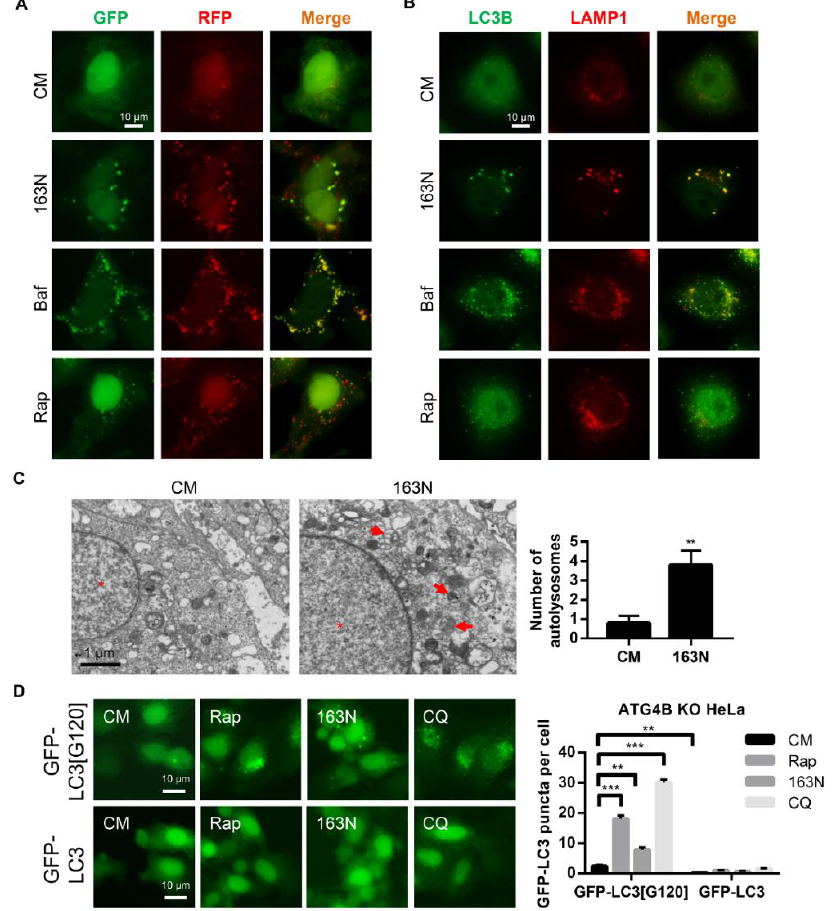
Figure 4. 163N increases the accumulation of autolysosomes. ( A ) HEK293A cells expressing green fluorescent protein (GFP)-red fluorescent protein (RFP)-LC3 were treated with 163N (10 µ M), rapamycin (Rap) (1 µ M) or Baf (0.5 µ M) for 6 h, then the colocalization of GFP and RFP puncta was detected. ( B ) HeLa cells were treated with 163N (10 µ M), Rap (1 µ M) or Baf (0.5 µ M) for 6 h, then immunostaining was used to detect LC3B and LAMP1. The colocalization of LC3B and LAMP1 was measured. ( C ) HeLa cells were treated with 163N (10 µ M) for 6 h, then transmission electron microscopy (TEM) was used to detect the ultrastructure of HeLa cells. Red arrows indicate normal autolysosome structures. ( D ) ATG4BKO HeLa cells expressing GFP-LC3[G120] or full length GFP-LC3 were treated with Rap (1 µ M), 163N (10 µ M), or CQ (40 µ M) for 6 h, then the distribution of GFP-LC3 was examined. And the number of GFP-LC3 dots were quantified. Data are presented as mean ± SEM from three individual experiments. * p < 0.05, ** p < 0.01, *** p < 0.001.